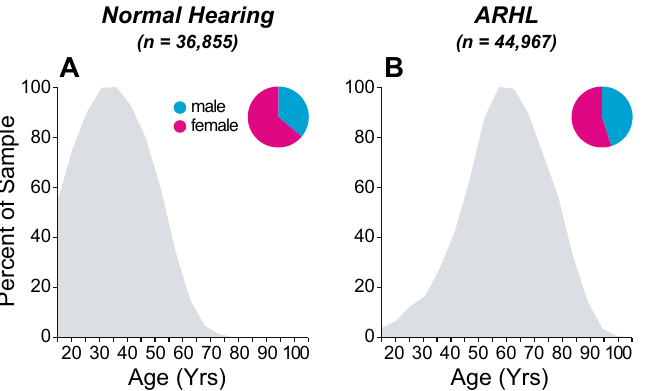
Figure 2. Age distribution of study population split between a group of normal hearing patients ( A ) and one with sensorineural hearing loss ( B ). Pie charts indicate the proportion of male (cyan) vs. female (magenta) for each group.